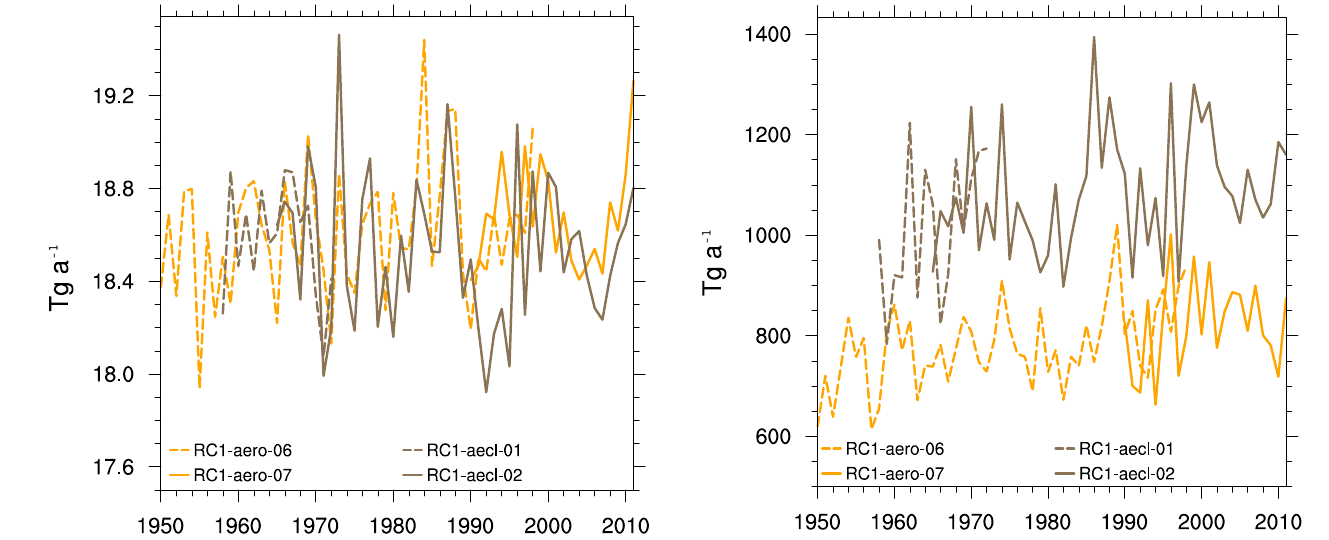
Figure 9. Simulated annual total emissions of POC (in Tg ( C ) a − 1 ) from the ocean.